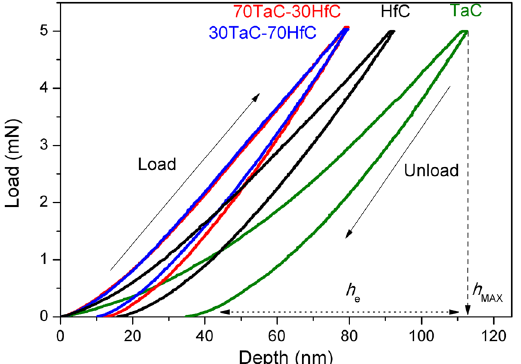
Figure 5. Load-displacement nanoindentation curves of the Ta-Hf-C films, showing the load and unloading regions of the curves. The line-dashed line shows the maximum penetration ( h MAX ) of the TaC curve and dot- dashed line shows the elastic recovery region ( h e )